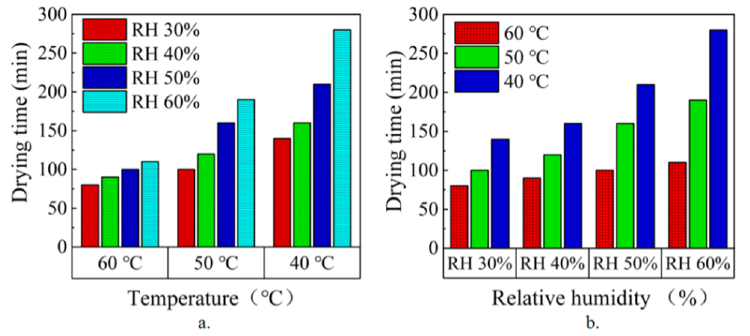
Figure 4. Plot of drying time versus ( a ) temperature and ( b ) relative humidity.